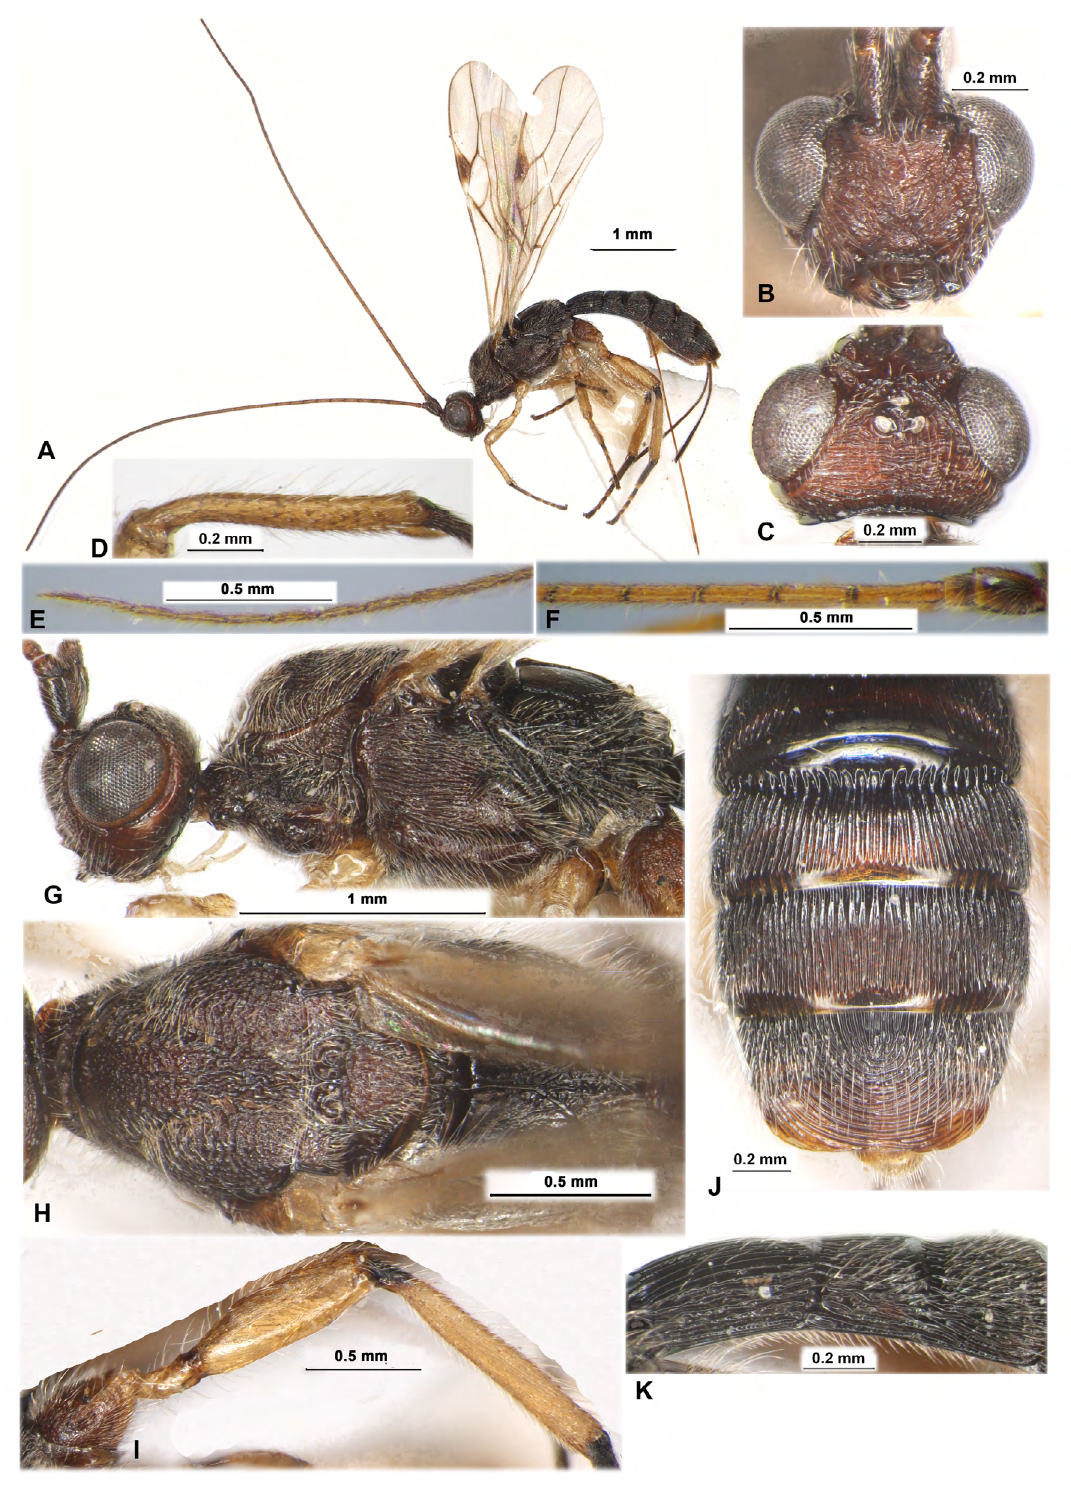
Fig. 24. Mimipodoryctes rubriceps (Cameron, 1909), ♀, holotype of M. robustus Belokobylskij, 2000, ZISP. A . Habitus, lateral view. B . Head, front view. C . Head, dorsal view. D . Fore tibia, lateral view. E . Apical segments of antenna. F . Basal segments of antenna. G . Head and mesosoma, lateral view. H . Mesosoma, dorsal view. I . Hind leg, lateral view. J . Apical metasomal tergites, dorsal view. K . First to third metasomal tergites, lateral